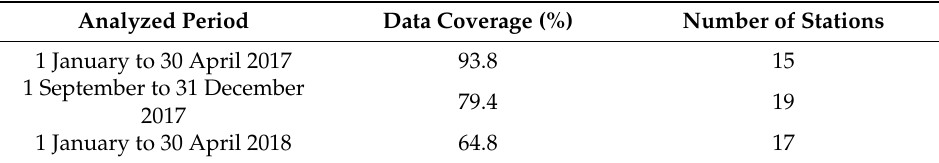
Table 5. Number of stations used in analyses for particular subperiods and data coverage.